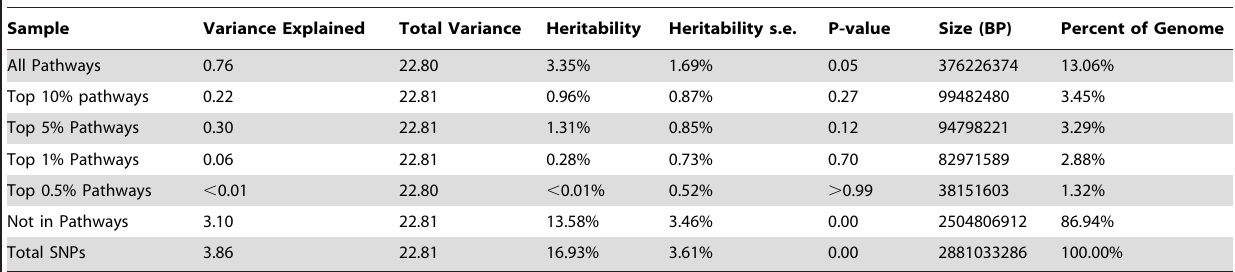
Table 4. Partitioned heritability